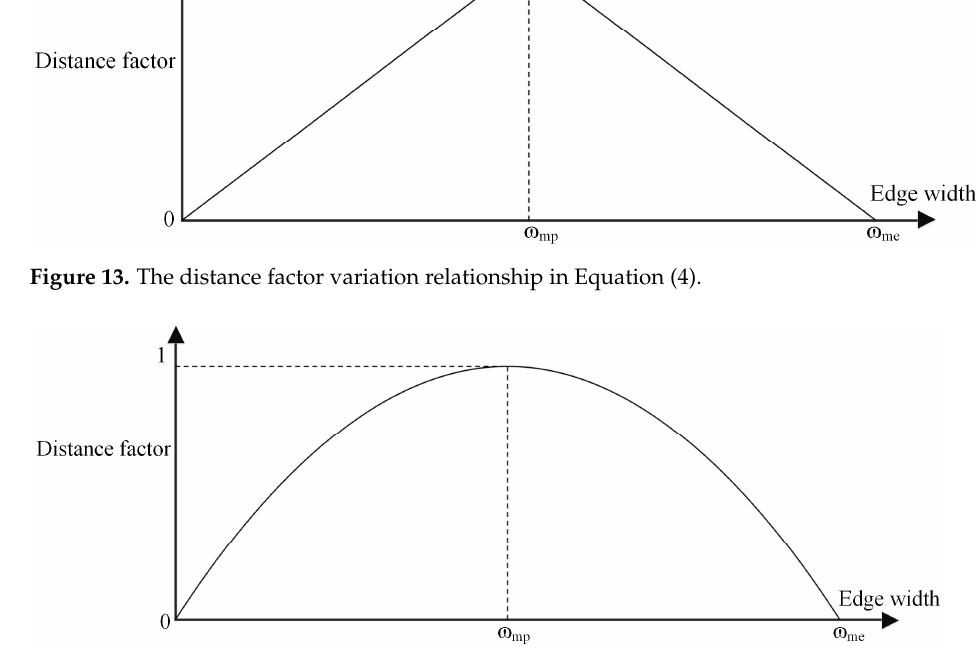
Figure 12. The distance factor variation relationship in Equation (3).